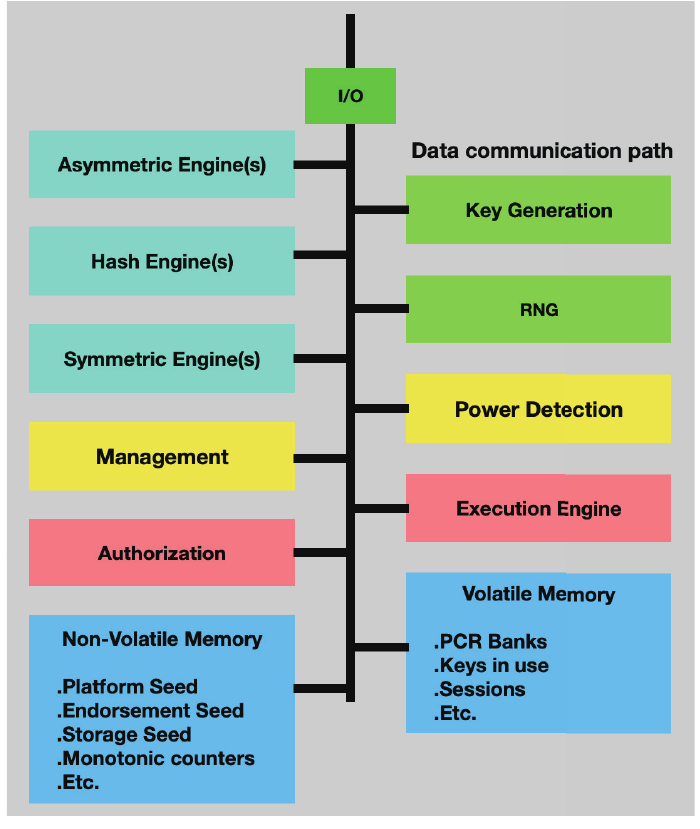
Figure 11. TPM architecture